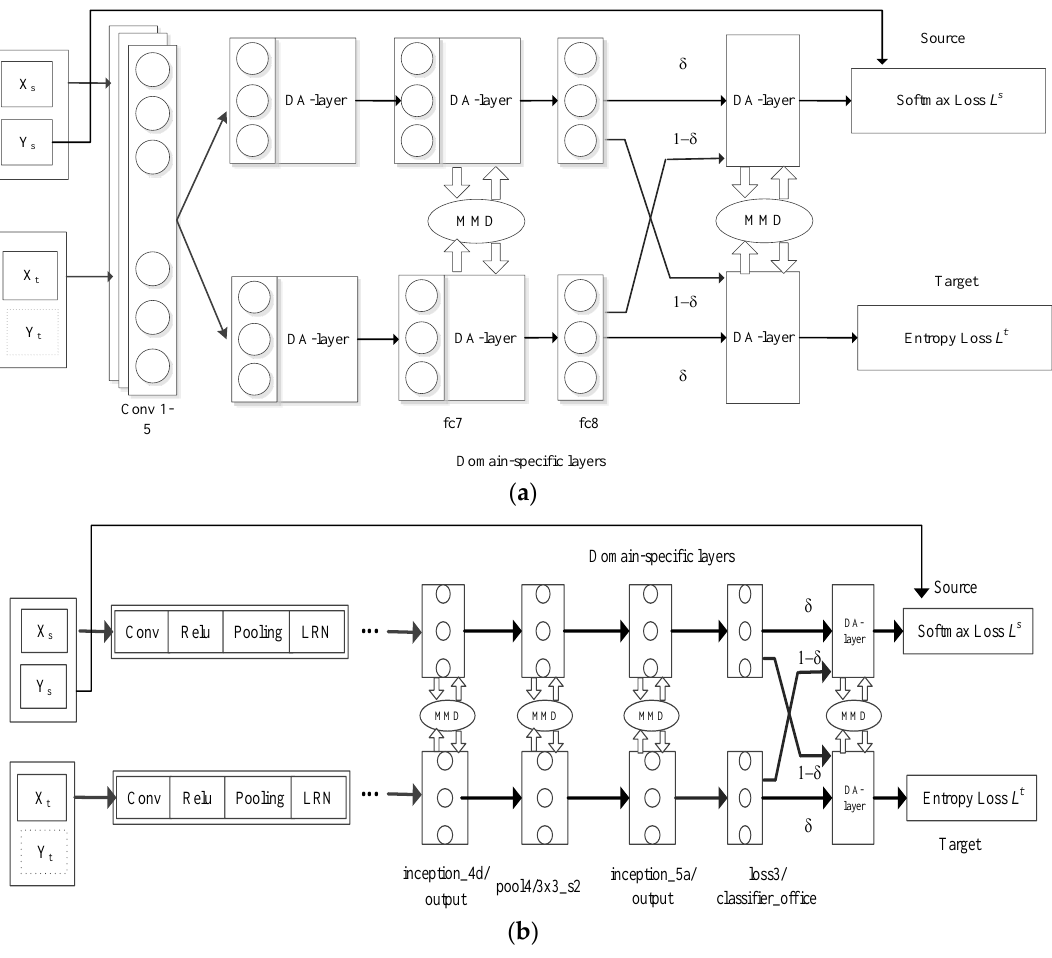
Figure 1. Network architecture of the proposed method: ( a ) architecture based on AlexNet for unsupervised domain adaptation; ( b ) architecture based on GoogLeNet for unsupervised domain adaptation.